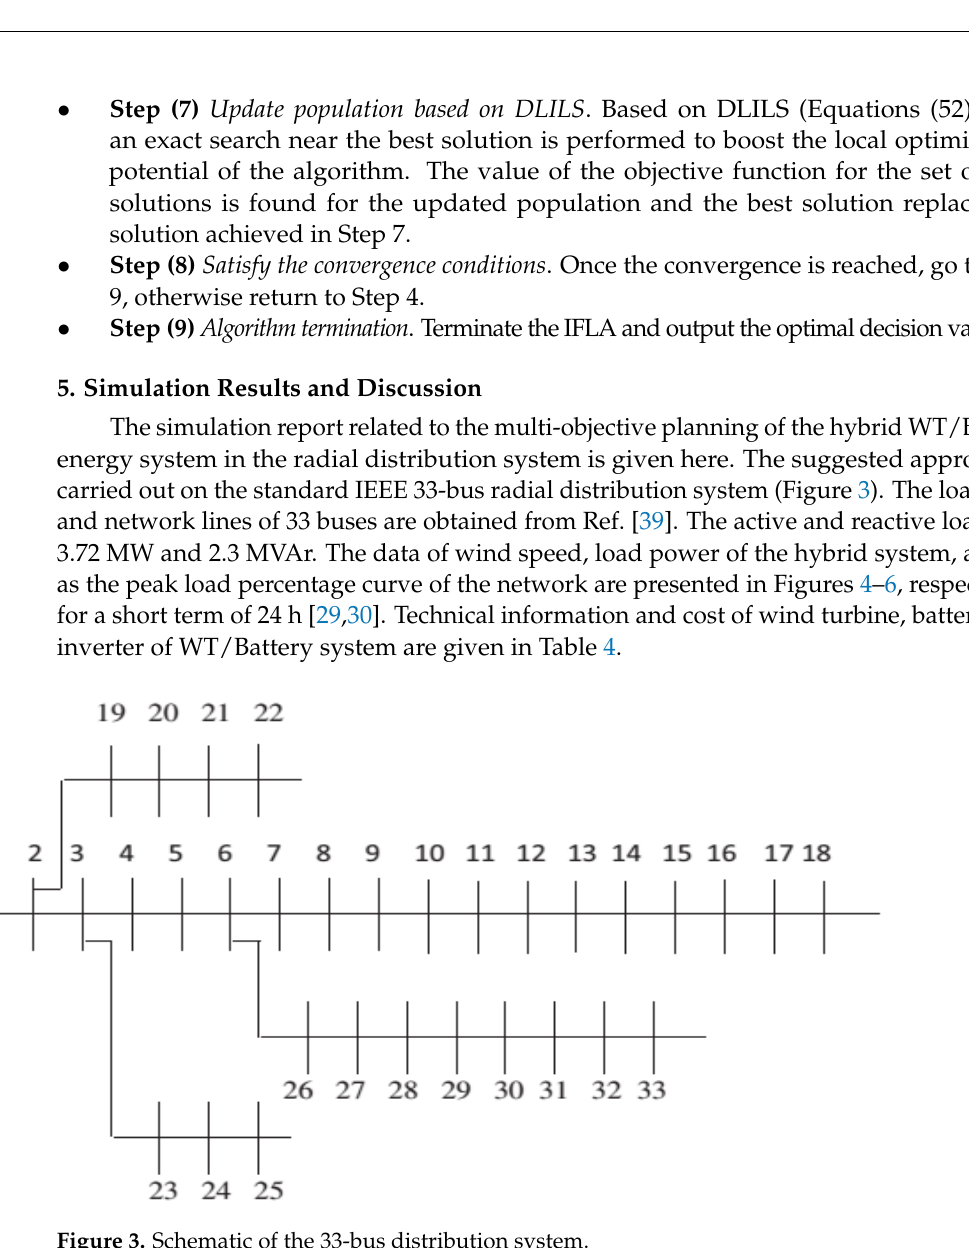
Figure 3. Schematic of the 33-bus distribution system.